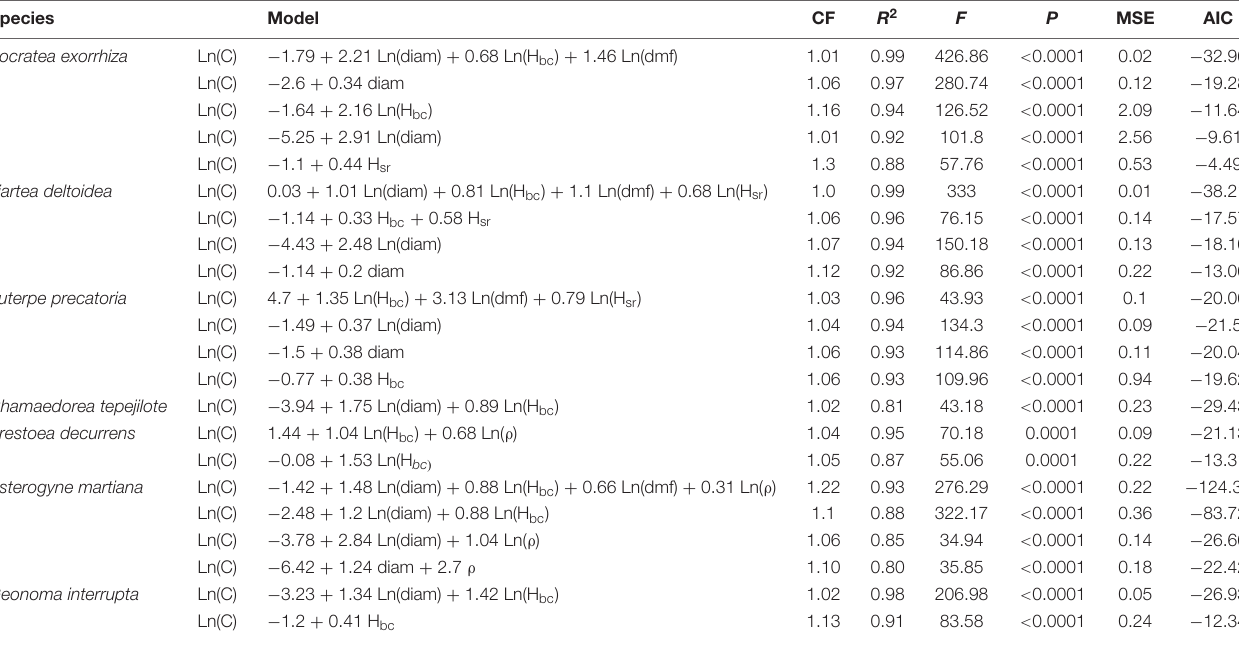
TABLE 1 | Models to estimate carbon content (C; Ln kg), in seven species of neotropical palms. Species